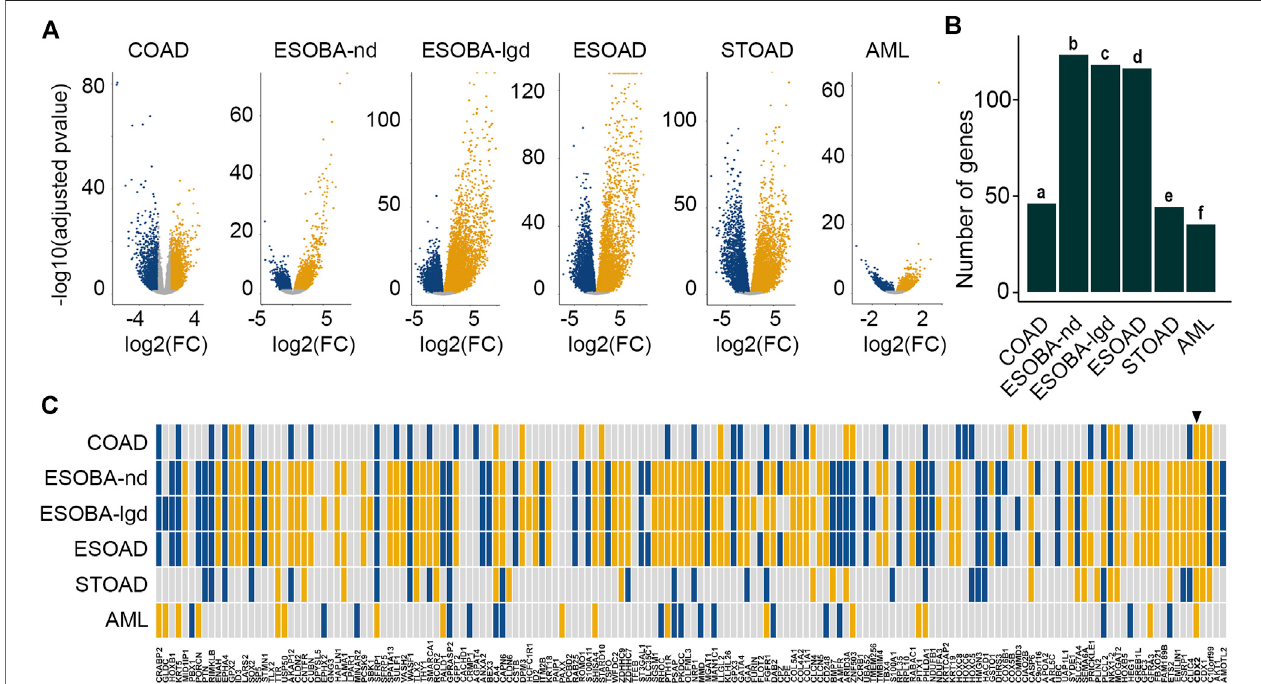
FIGURE 4 | Human orthologues to the core set of mouse DEGs deregulated in diseases. ( A ) Volcano plots of the differentially expressed genes in colon adenocarcinoma (COAD), in esophageal non-dysplastic Barrett metaplasia (ESOBA-nd), low-grade dysplastic Barrett metaplasia (ESOBA-lgd) and adenocarcinoma (ESOAD), in gastric adenocarcinoma (STOAD) and in acute myeloid leukemia (AML); up-regulated (yellow), down-regulated (blue), not signi fi cant (grey). ( B ) Enrichment analysisofthesetof162humanorthologuestothemousecoresetofDEGsamongthedifferentiallyexpressedgenesinhumandiseases. p -valuesarea (cid:1) 0.044;b (cid:1) 0.16 E − 73 ; c (cid:1) 0.21 E − 64 ; d (cid:1) 0.96 E − 44 ; e (cid:1) 0.0028; f (cid:1) 0.14 E − 4 . (C) Correlation map of the expression changes of the human orthologues to the mouse core set of DEGs in human diseases (yellow: up-regulation; blue: down-regulation). In each case, the map illustrates the comparison of the CDX2-high expressing samples vs CDX2 non-expressing or low-expressing counterparts. The arrowhead shows CDX2. The order of the genes is the same as in Figure 1B .